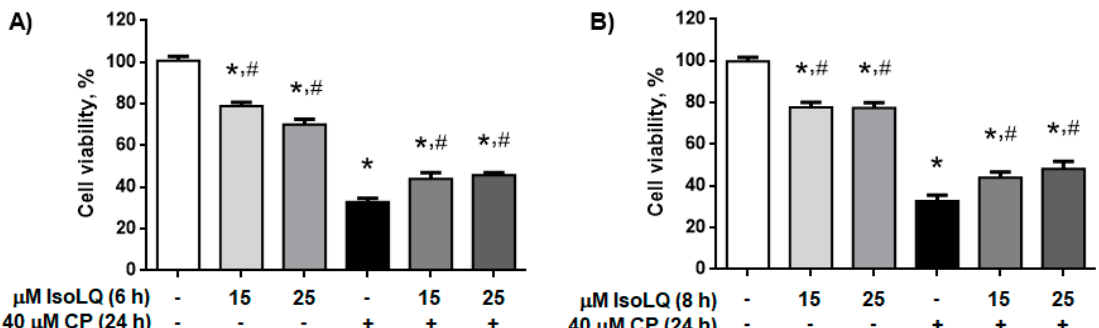
Figure 4. Isoliquiritigenin (IsoLQ) pretreatment attenuated cell viability decrease in cisplatin (CP)-induced toxicity. ( A ) 6 h IsoLQ pretreatment, ( B ) 8 h IsoLQ pretreatment. Data are mean ± SEM, n = 3. * p < 0.05 vs. control (without IsoLQ and CP), # p < 0.05 vs. CP.